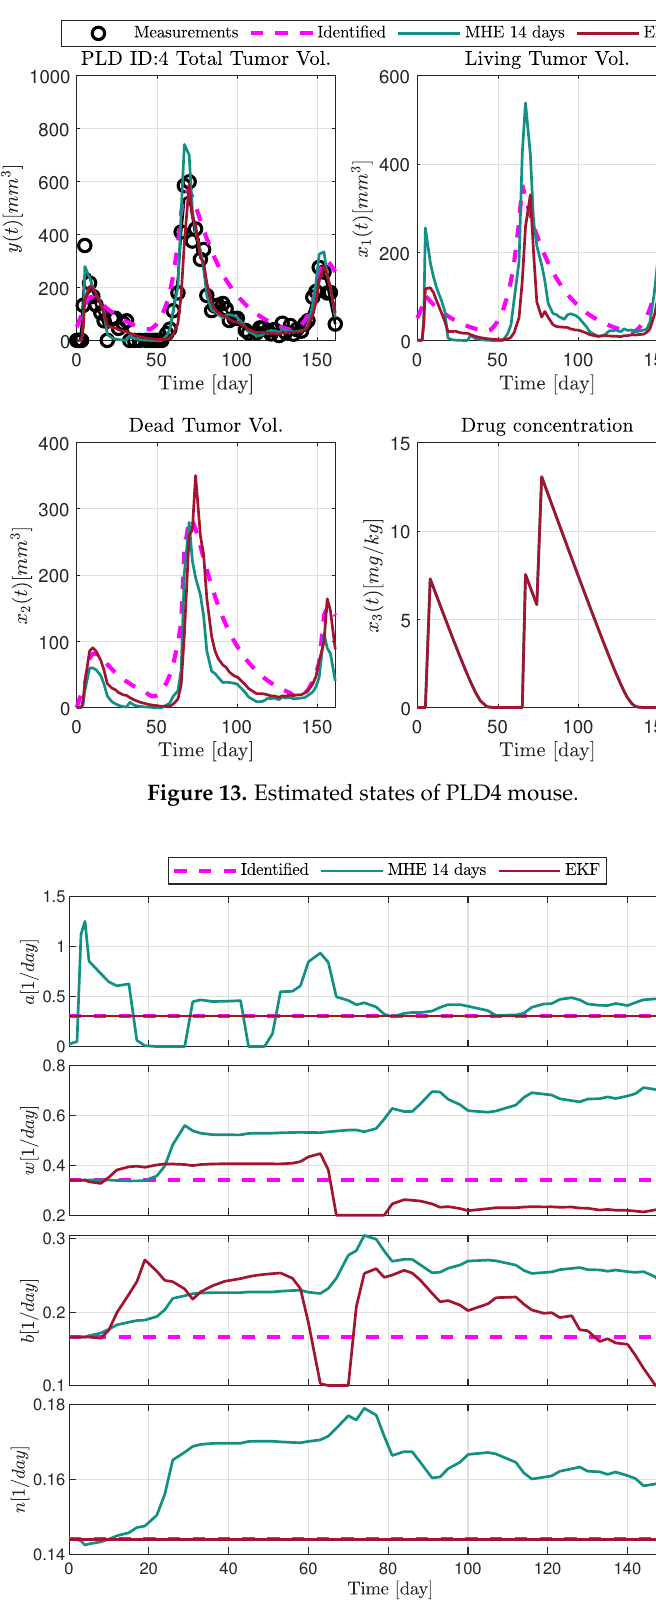
Figure 14. Estimated parameters of PLD4